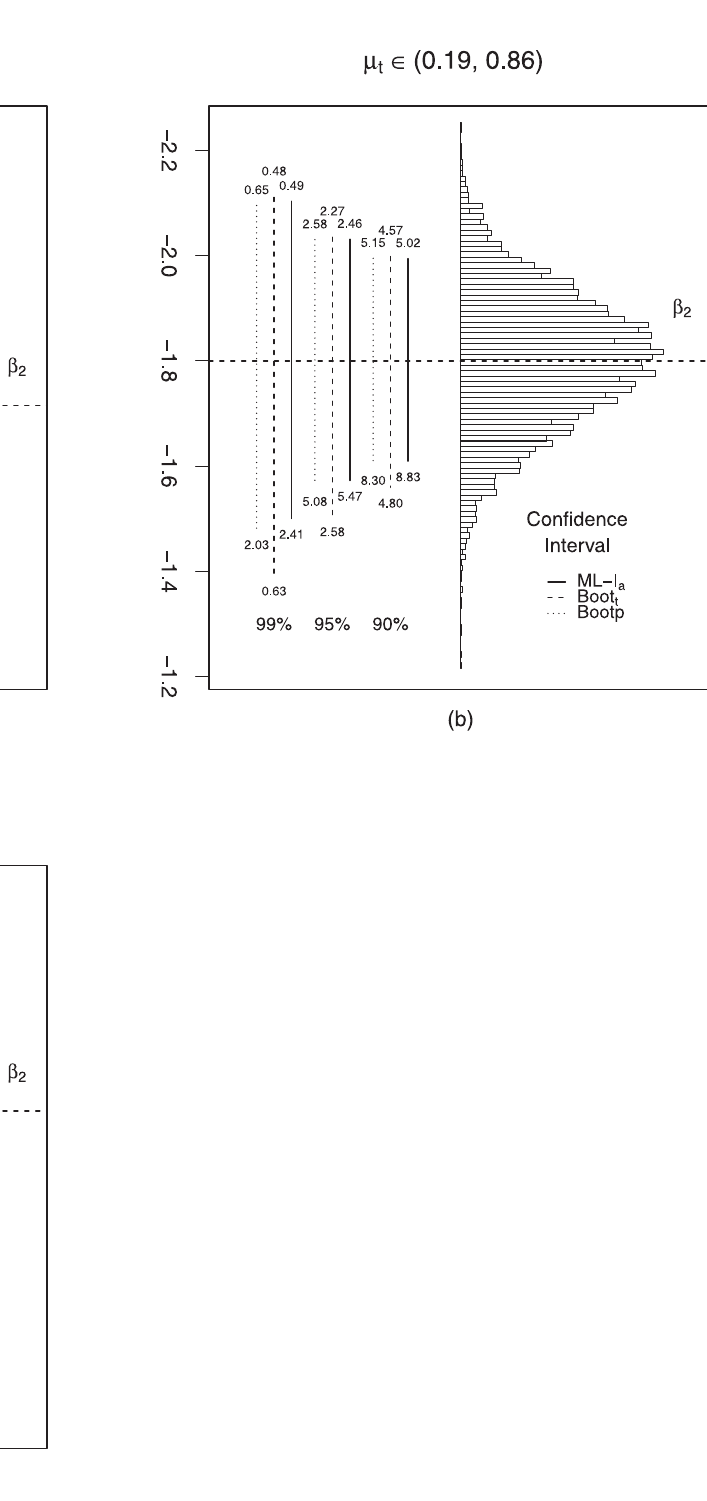
Fig 1. Interval estimation for β 2 , n = 40, λ � 128. ( a ) β 2 = 1.2, ( b ) β 2 = − 1.8 and ( c ) β 2 = − 1.5.